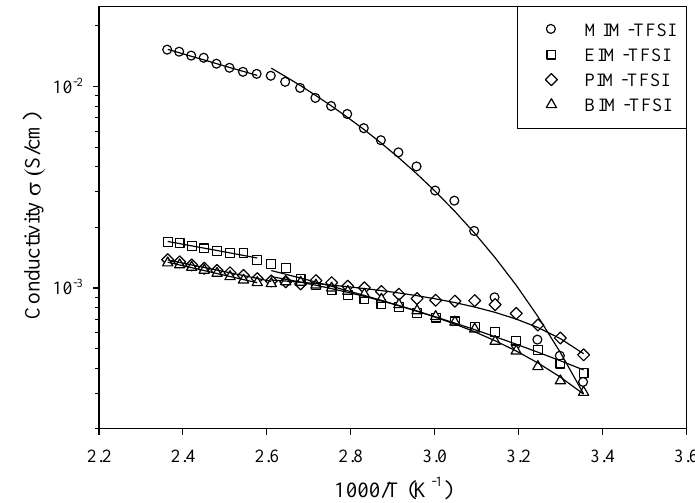
Figure 3. Temperature dependence of the conductivity for synthesized PILs. Solid lines are the best fit of the Arrhenius (Equation (2)) and VFT (Equation (4)) equations.